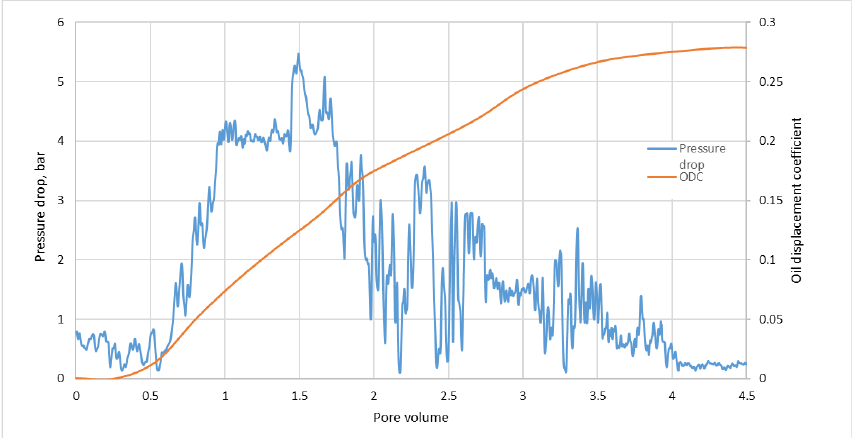
Figure 1. Pressure drop and oil displacement coefficient in experiment № 1. The maximum value of pressure drop is 5.3 bar. The oil displacement coefficient reaches its maximum value at pumping 4.5 pore volume (PV) of steam, and the greatest growth of the displacement coefficient falls on the first 3 PV. The mass of displaced oil during the experiment was 41.9 g, and the displacement coefficient is 27.9%. Results of filtration experiment № 2. Steam injection with solvent at 300 °C. The dynamics of changes in pressure drop and oil displacement coefficient in the second experiment are shown in Figure 2.